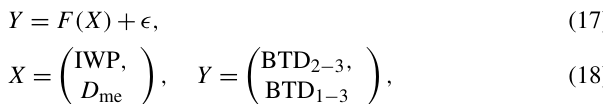
to 12, and the range of values is defined in log10 space from